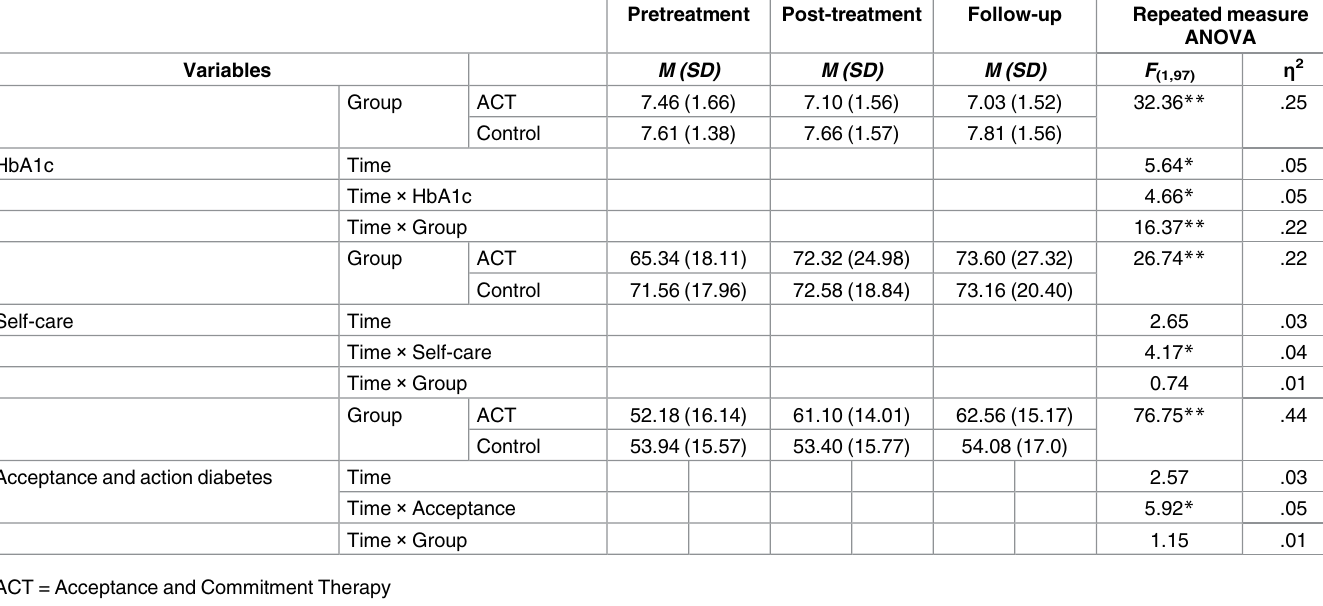
Table 2. Results of Repeated Measure ANOVA for effect of the ACT on HbA1c, self-care and acceptance. Pretreatment Post-treatment